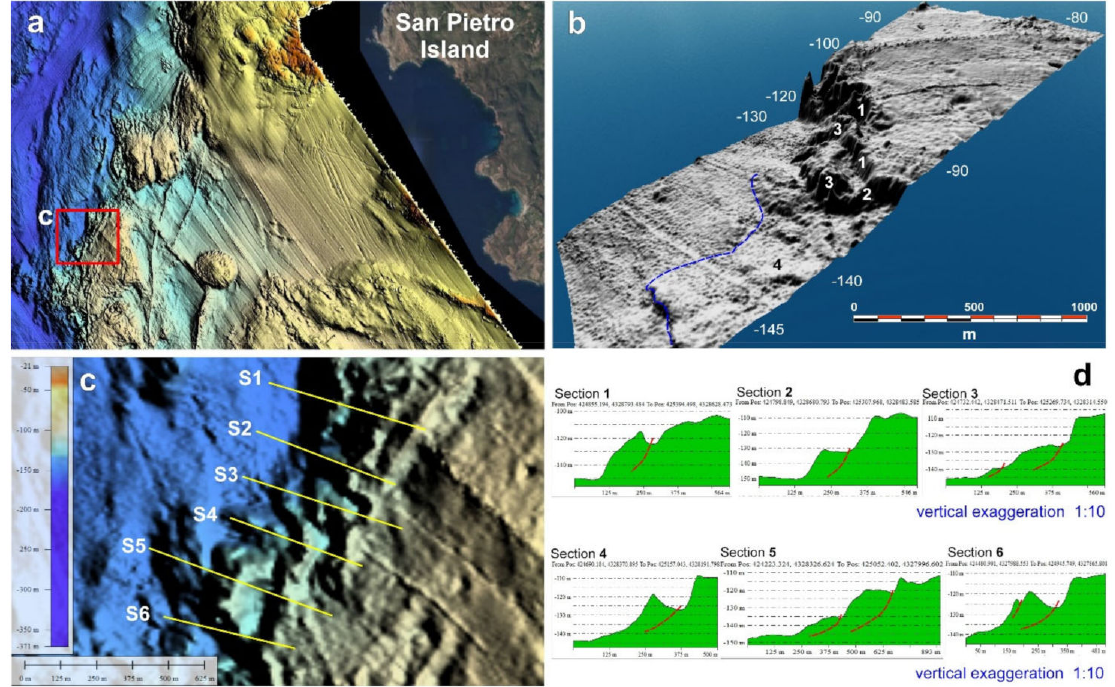
Figure 9. ( a ) DTM from MBES data showing the Last Glacial Maximum (LGM) palaeo-cliffs. ( b ) DTM 3D from MBES data showing some landslides affecting the submerged palaeo-cliffs: 1—main scarp; 2—distensional trench; 3—landslide bodies; LGM palaeo-sea-level (blue line). ( c ) detail of tectonic controlled palaeo-cliffs with localization of morphometric profiles. ( d ) Morphometric sections and hypothesized sliding surfaces (red